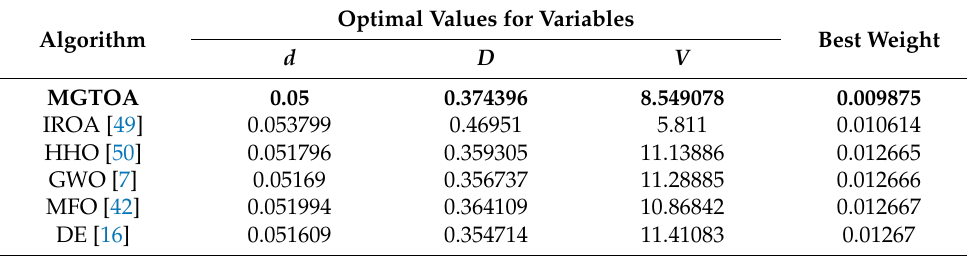
Table 12. Experimental results of tension/Compression Spring Design.